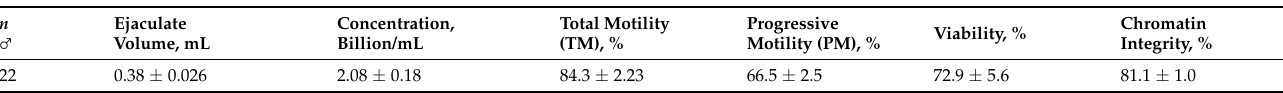
Table 1. Indicators of qualitative assessment of individual ejaculates of native semen of Russian White roosters (Maen ± SEM).